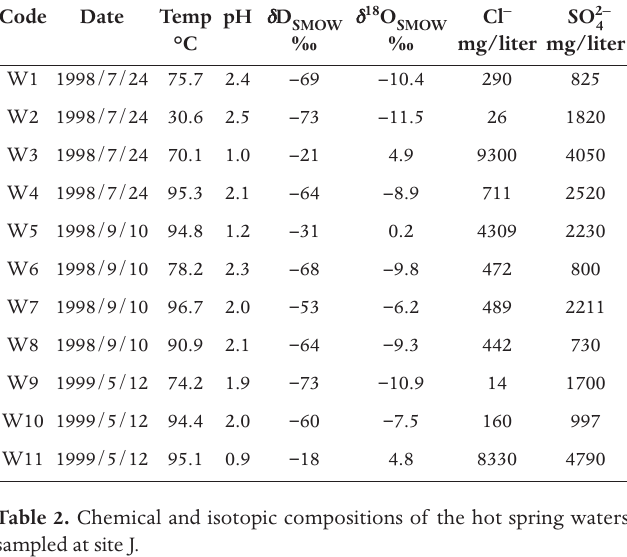
O-CO -S ternary diagram (S = H 2 2